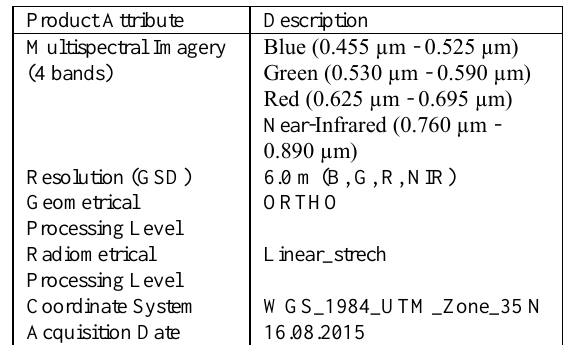
under the root mean square error of 0.5 pixels.